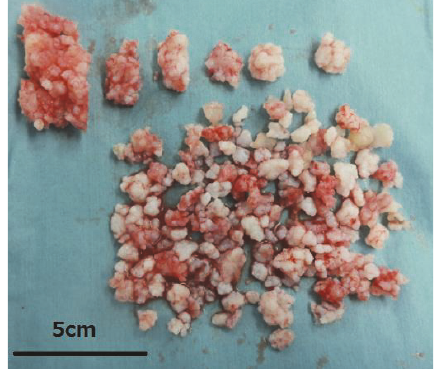
Figure 9: Excised osteochondromas of case 2